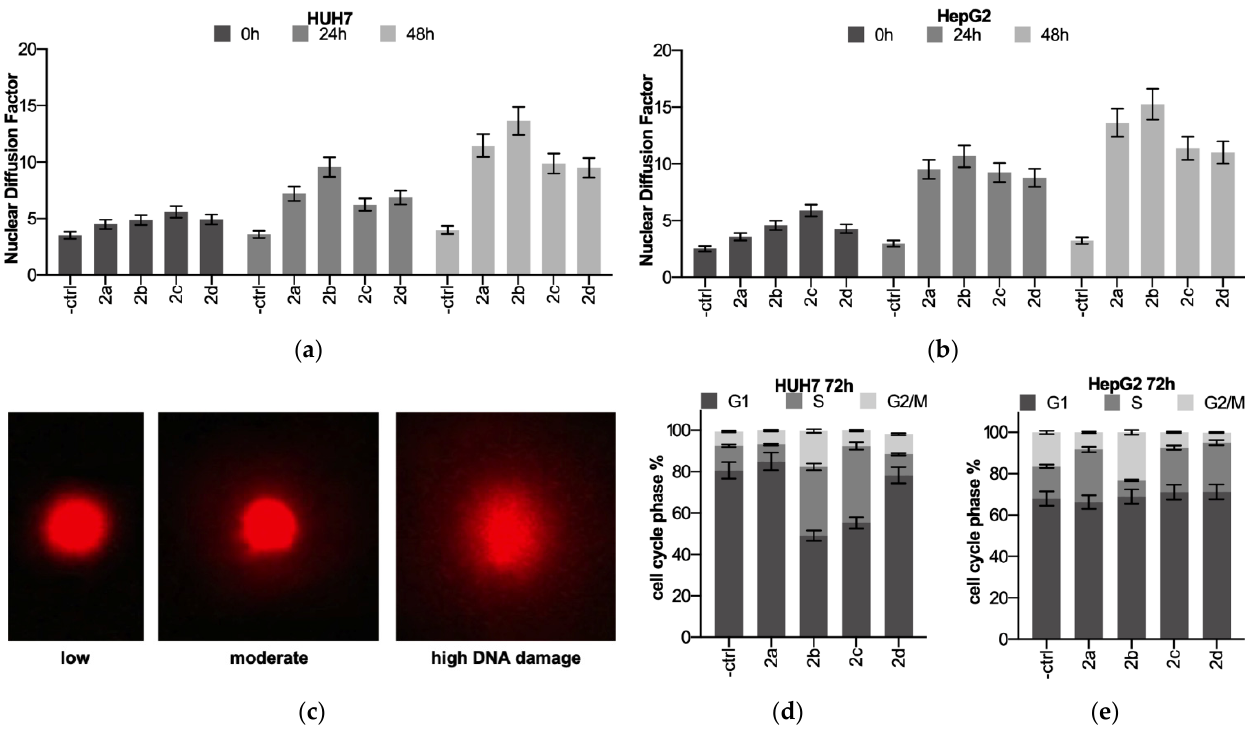
Figure 9. Measurement of DNA damage generated by the tested compounds in ( a ) HUH7 and ( b ) HepG2 cell lines. DNA damage was presented as the Nuclear Diffusion Factor. ( c ) Photographs of a representative cell nucleus observed during the DNA damage test. Small, medium, and large DNA damage can be seen, visible in the photograph as a gradually growing halo around the undamaged DNA. Images were taken using an Olympus IX70 microscope at 400× magnification. Cell-cycle distribution of ( d ) HUH7 and ( e ) HepG2 cell lines. The cell cycle was analyzed cytometrically after 72 h of treatment with 2a – 2d used at their IC 50 . The percentage of DNA at a particular cell-cycle phase was calculated from DNA histograms. Single experiments were carried out at least in triplicate, each with 3 to 4 repeats. Data were expressed as mean and SD. The significance of differences was estimated based on multifactor ANOVA and post-hoc Tukey tests. Statistical analysis for Fast HALO Assay: HepG2+2a: p < 0.001: control vs. IC 50 (24 h and 48 h); IC 50 0 h vs. IC 50